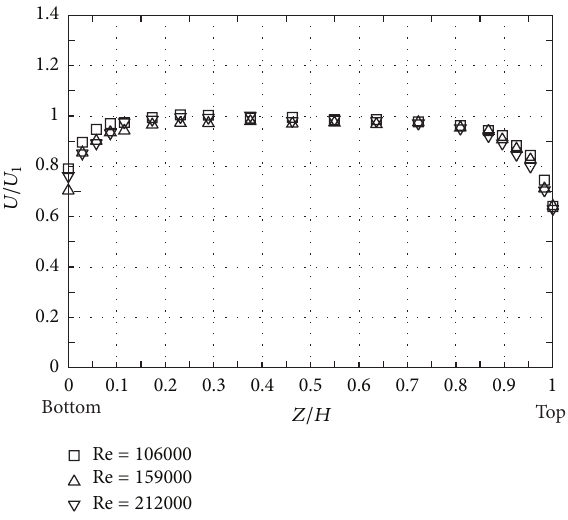
Figure 5: Inlet velocity profile.